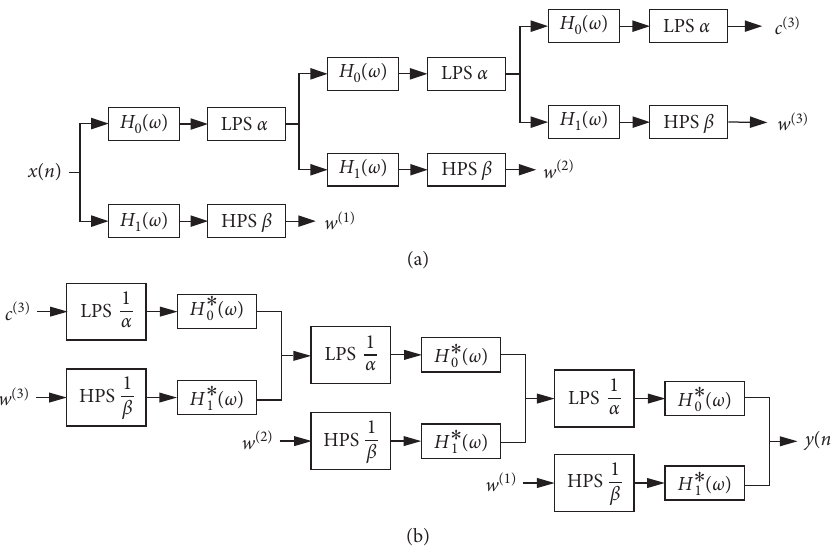
Figure 1: Decomposition and reconstructed filter bank of TQWT. (a) Decomposition filter bank. (b) Reconstructed filter